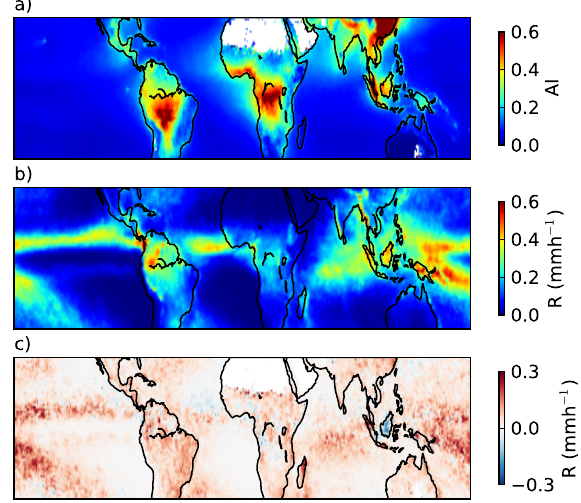
Figure 1. (a) The annual mean MODIS aerosol index (AI) in the re- gion studied (30 ◦ N–30 ◦ S) for the years 2005–2007. (b) The annual mean TRMM 3B42 merged precipitation rate in the same region. (c) The difference in TRMM 3B42 precipitation rate between days in the highest AI quartile and days in the lowest AI quartile, with red indicating an increase in precipitation at high AI (based on Koren et al.,